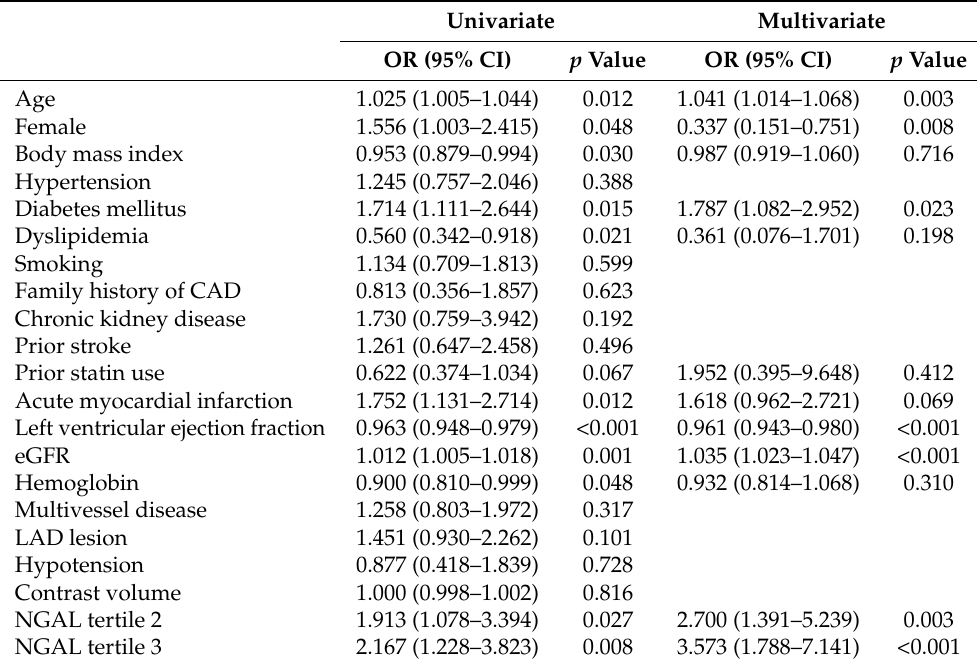
Figure 1. The incidence of contrast-induced acute kidney injury according to tertiles of baseline serum NGAL. Table 2. Associations between clinical characteristics and the risk of contrast-induced acute kidney injury according to univariate and multivariate logistic regression